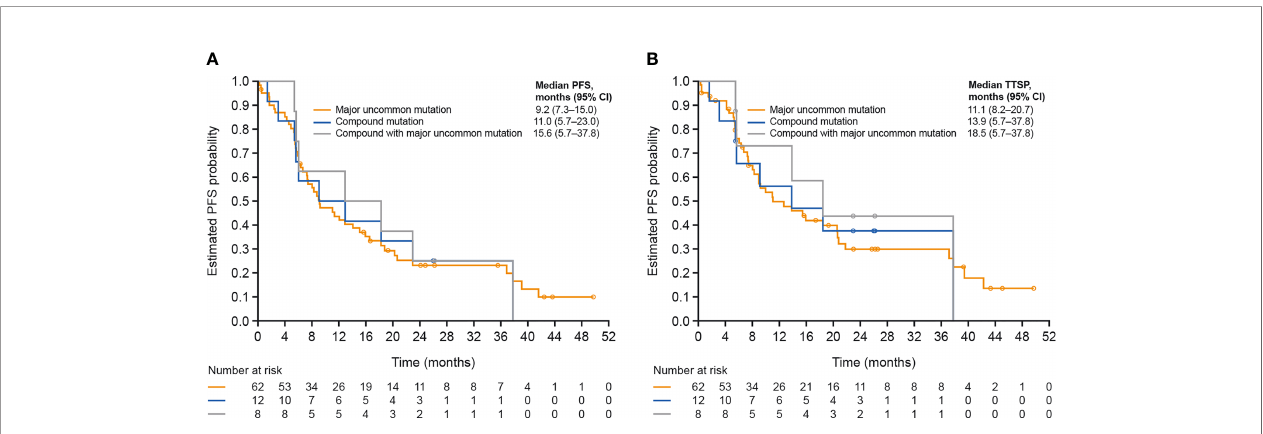
FIGURE 2 | (A) PFS and (B) TTSP according to type of uncommon EGFR mutation. CI, con fi dence interval; EGFR, epidermal growth factor receptor; PFS, progression-free survival; TTSP, time to symptomatic progression.